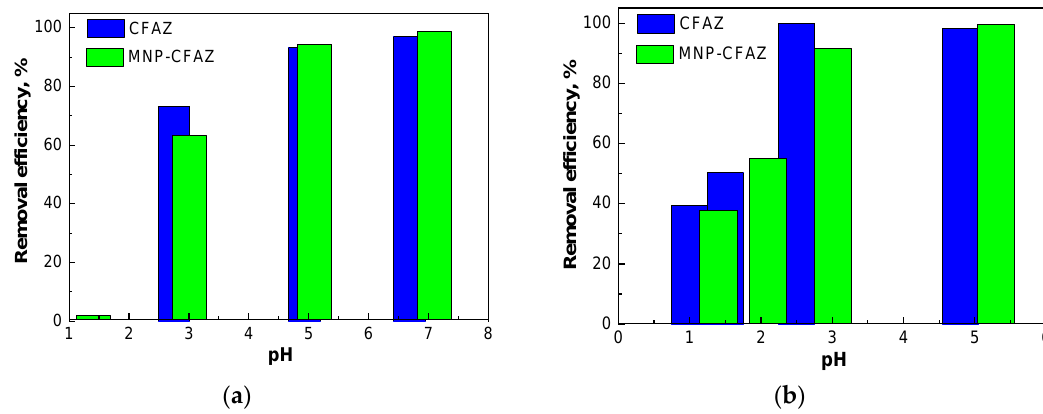
Figure 8. Effect of pH values on the adsorption efficiency of CFAZ and MNP-CFAZ: ( a ) toward Cd 2+ - Figure 8. E ff ect of pH values on the adsorption e ffi ciency of CFAZ and MNP-CFAZ: ( a ) toward ions; ( b ) toward Pb 2+ -ions. Cd 2 + -ions; ( b ) toward Pb 2 + -ions.